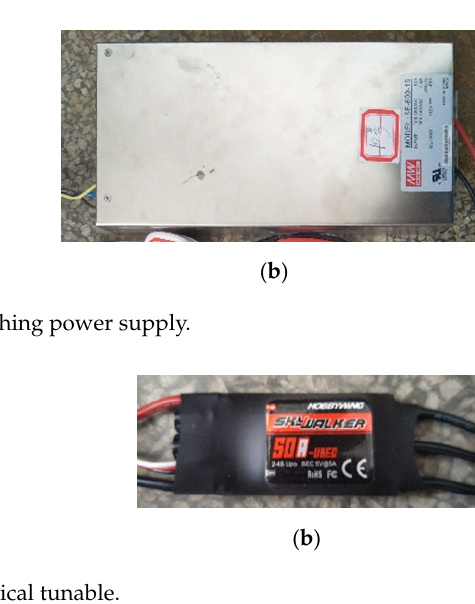
Figure 6. Airfoil model installed in the 4 m × 3 m wind tunnel.